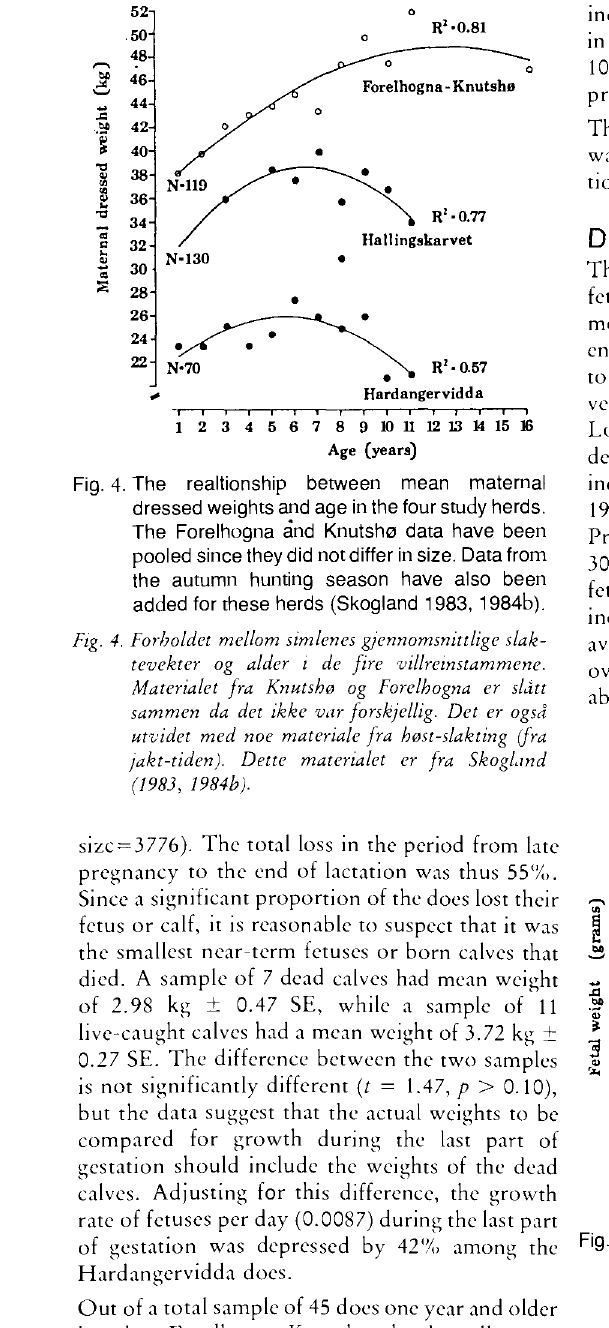
Fig. 5. Mean fetal weights in relation to maternal ages. The Forelhogna-Knutshø and the Hallingskarvet data are from February, while the Hardanger vidda data are from March. Fig. 5. Gjennomsnittlige fostervekter i forhold til simlenes alder. Materialet fra Forelhogna, Knutshø og Hallingskarvet er fra februar, mens Hardanger vidda materialet er fra